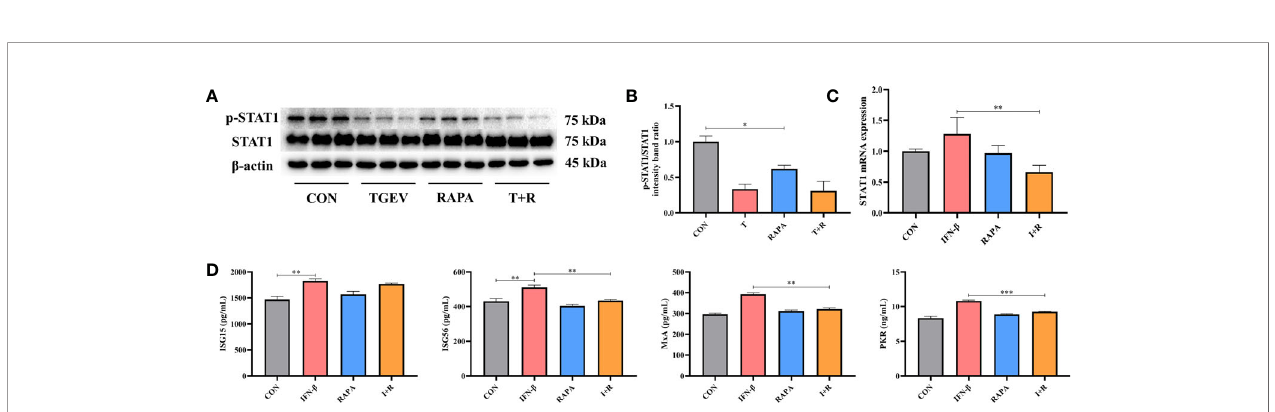
FIGURE 6 | The expressions of STAT1 and ISGs was lessened by RAPA pretreatment. (A) Both p-STAT1 and T-STAT1 levels were detected by western blot. (B) Quantitation of bands to demonstrate the protein level of p-STAT1/STAT1. Data express the means ± SEMs (n = 3). (C) The mRNA expression of STAT1 were analyzed via RT-qPCR. Data express the means ± SEMs (n = 4). (D) The expressions of ISGs (ISG15, ISG56, MxA and PKR) were detected by ELISA. Data express the means ± SEMs (n = 3). The symbol * indicates statistically signi fi cant differences ( P < 0.05), ** P < 0.01 and *** P < 0.001.